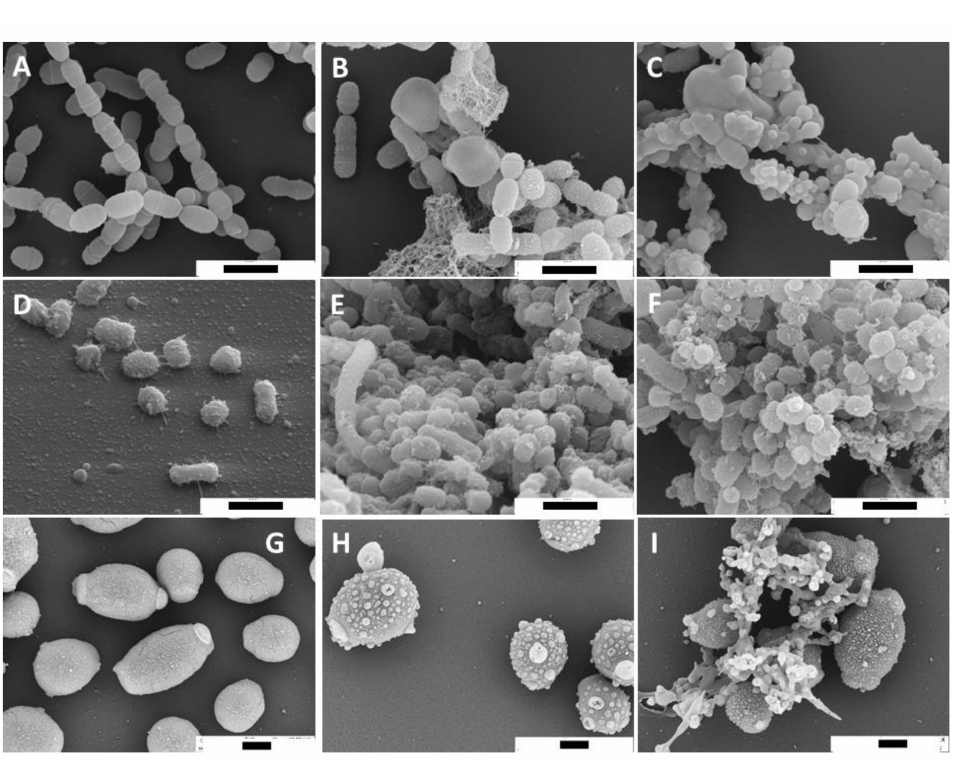
Figure 1. Scanning electron microscopy images of Streptococcus mutans ( A – C ), Porphyromonas gin- givalis ( D – F ), and Candida albicans ( G – I ) without ( A , D , G ) and with 5 min exposure to 25 mg/mL propolis of the different ethanolic propolis extracts (European: ( B , E , H ); green Brazilian: ( C , F , I )). Bar ( A – I ) 1 µ